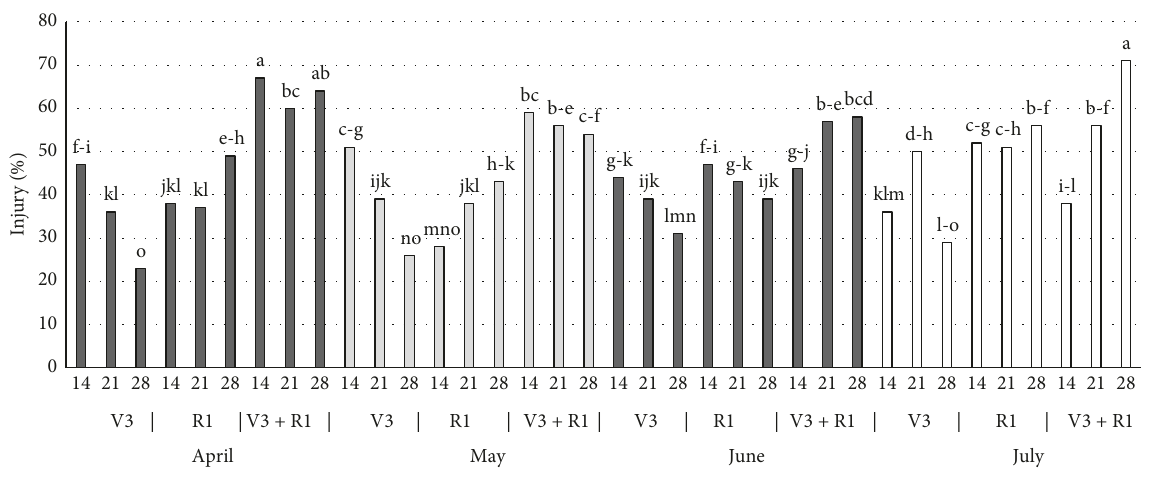
Figure 6: Visual estimates of soybean injury at 14, 21, and 28 days after a low-dose dicamba exposure at two growth stages ( V 3 and R 1) for April, May, June, and July planting dates in Fayetteville, AR, in 2019. Treatments not sharing any lowercase letter are significantly different according to multiple comparison analysis α � 0.05